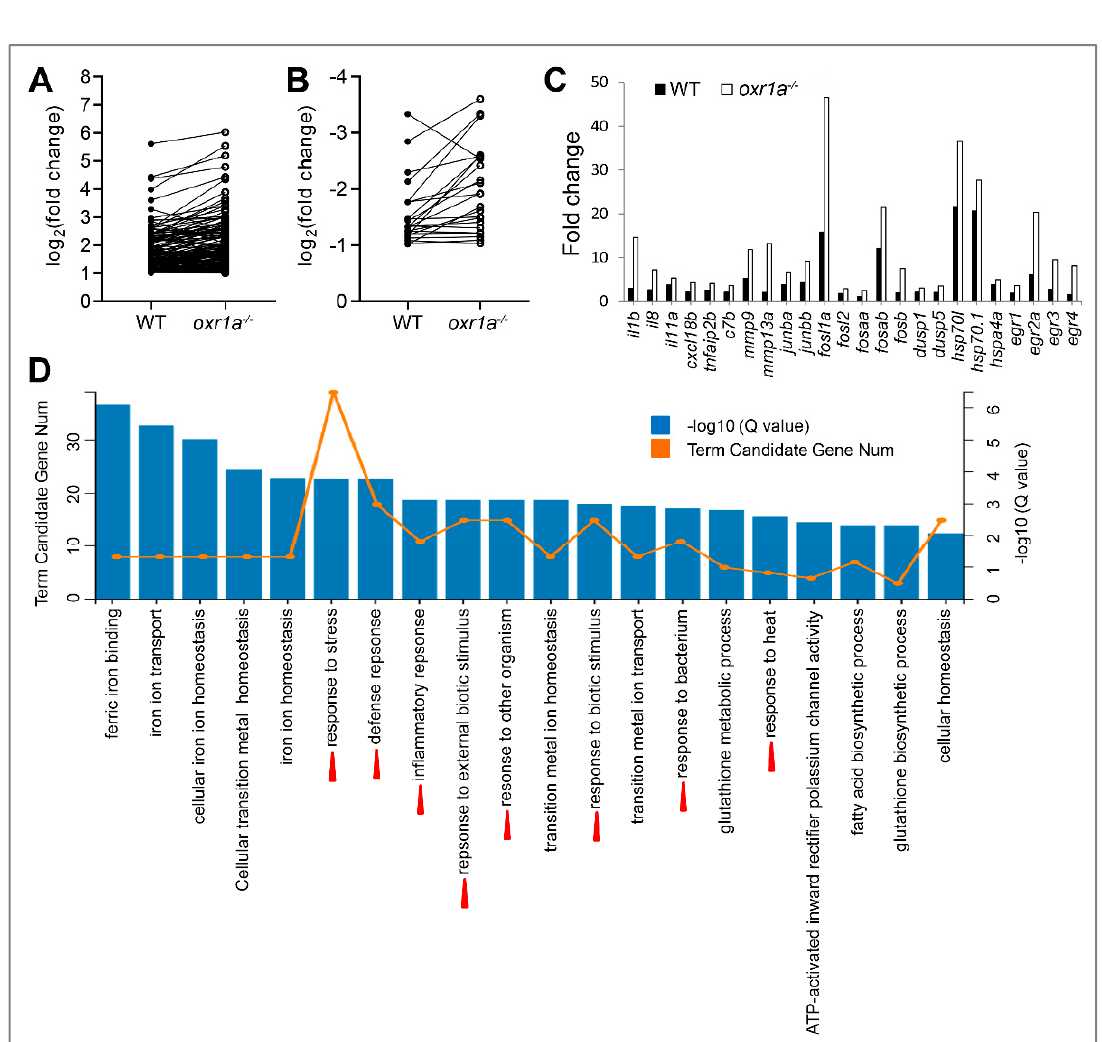
Figure 9. Comparative analysis for differentially expressed genes (DEGs) between WT and oxr1a − / − mutant zebrafish. ( A , B ) Commonly up- or downregulated genes in WT and oxr1a − / − mutant zebrafish during oxidative stress. Black solid and hollow circles indicate the fold change of gene expression in WT and oxr1a − / − mutant zebrafish after H 2 O 2 stress, respectively. ( C ) Most DEGs involved in early oxidative stress response and inflammatory reaction displayed significantly strong changes in oxr1a − / − mutant zebrafish. ( D ) Gene Ontology (GO) analysis of the DEGs in oxr1a − / − mutant zebrafish during oxidative stress. Red arrowheads show the early oxidative stress response pathways. The number of DEGs is shown in each biological process.